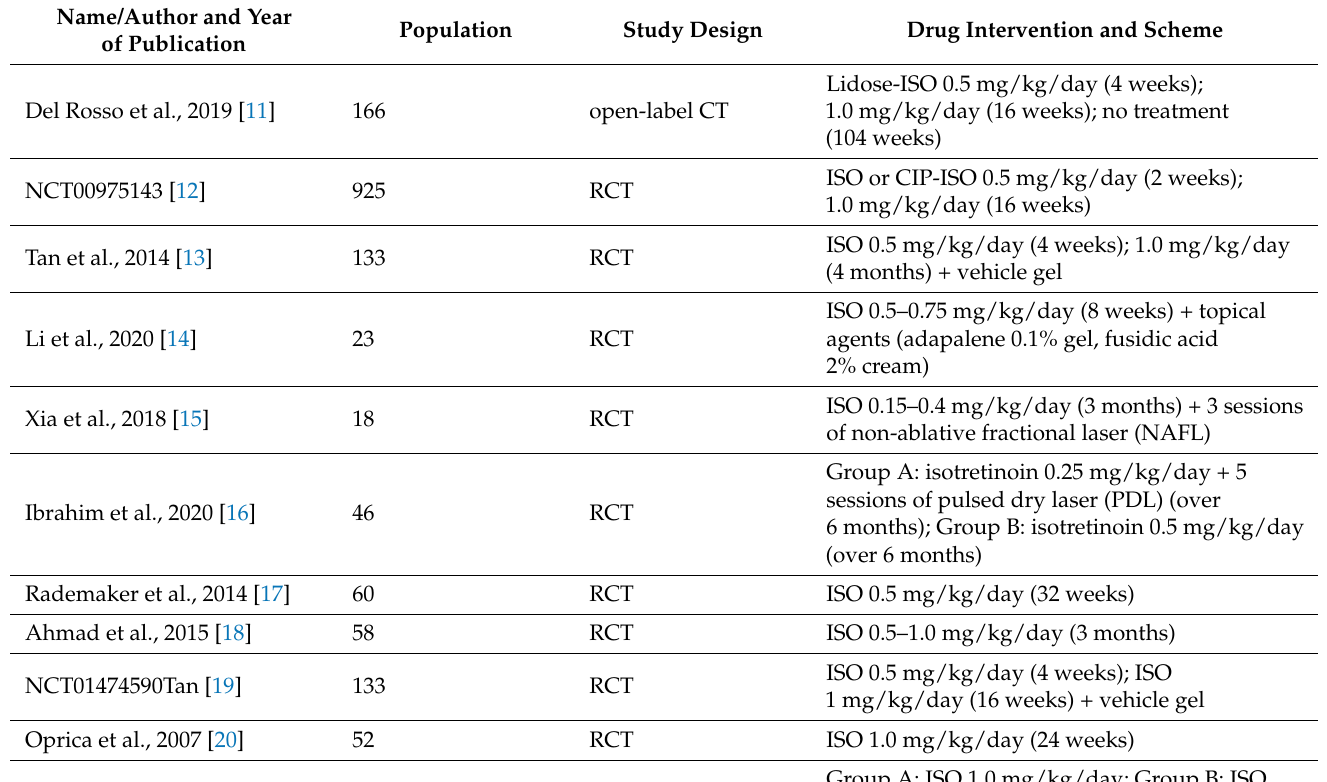
Table 2. Summary of included studies: clinical adverse events in isotretinoin